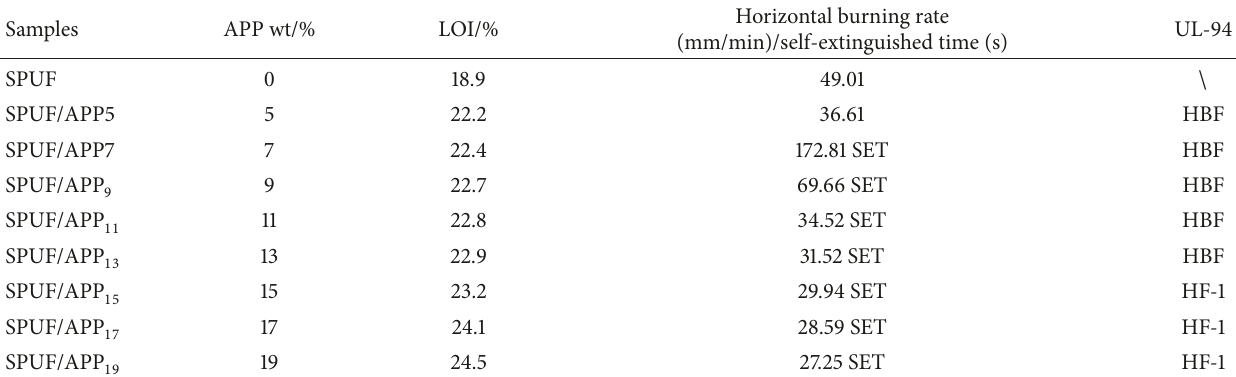
Table 1: Burning test results with different content APP for